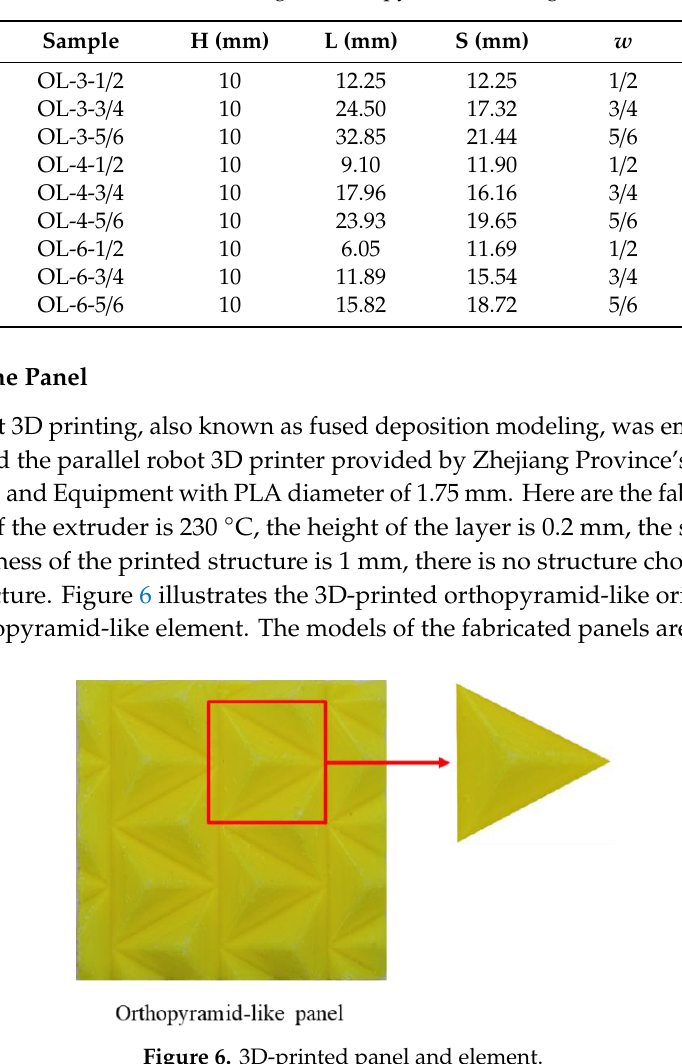
Figure 6. 3D-printed panel and element.